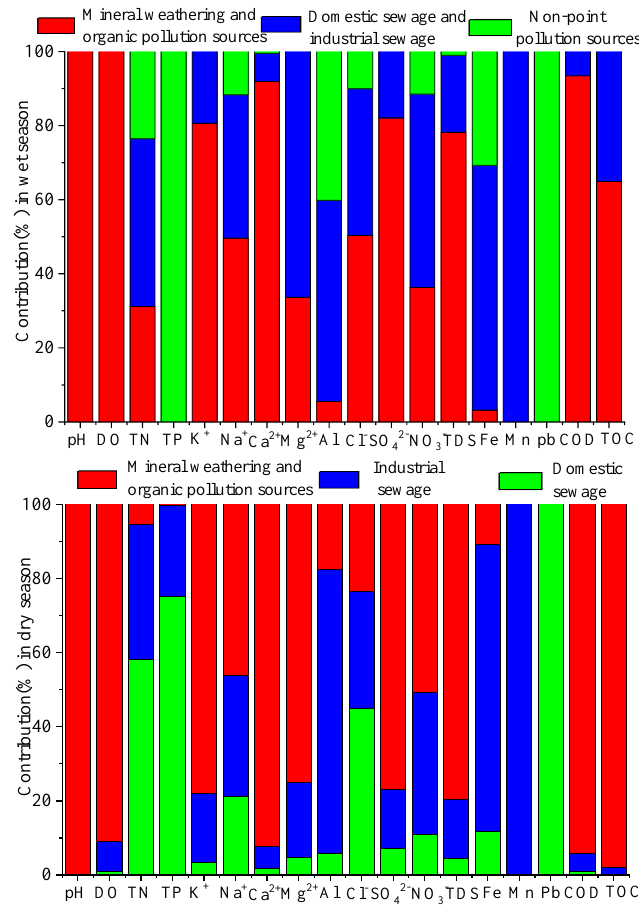
Figure 4. Factor figureprints of eighteen water quality variables resulted from the Environmental Protection Agency (EPA) PMF model in the wet and dry